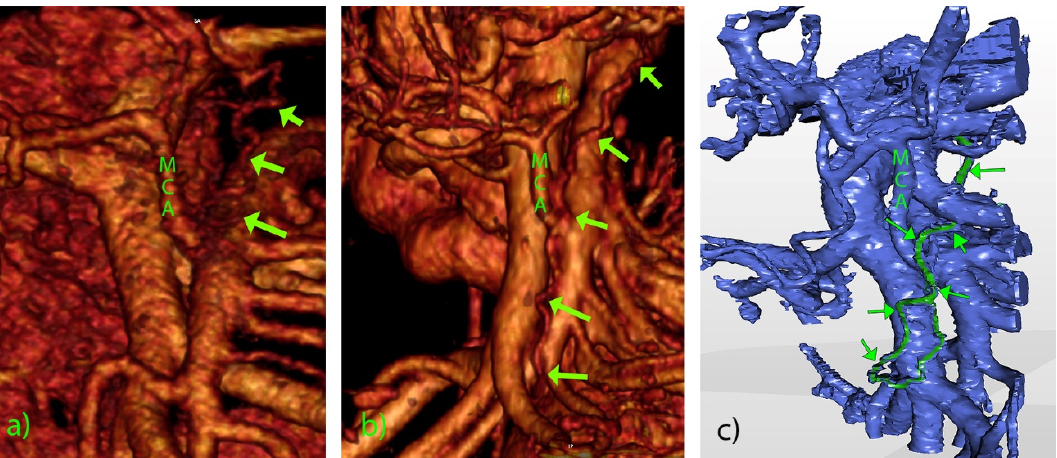
Figure 4. Three-dimensional volume rendering ( a , b ) and STL ( c ) of the D3 volume. Captions as in Figures 2 and 3. Serpiginous vessels (arrows) coursing from the MCA level ( a ) or the level of the ileocolic vessels ( b , c ).